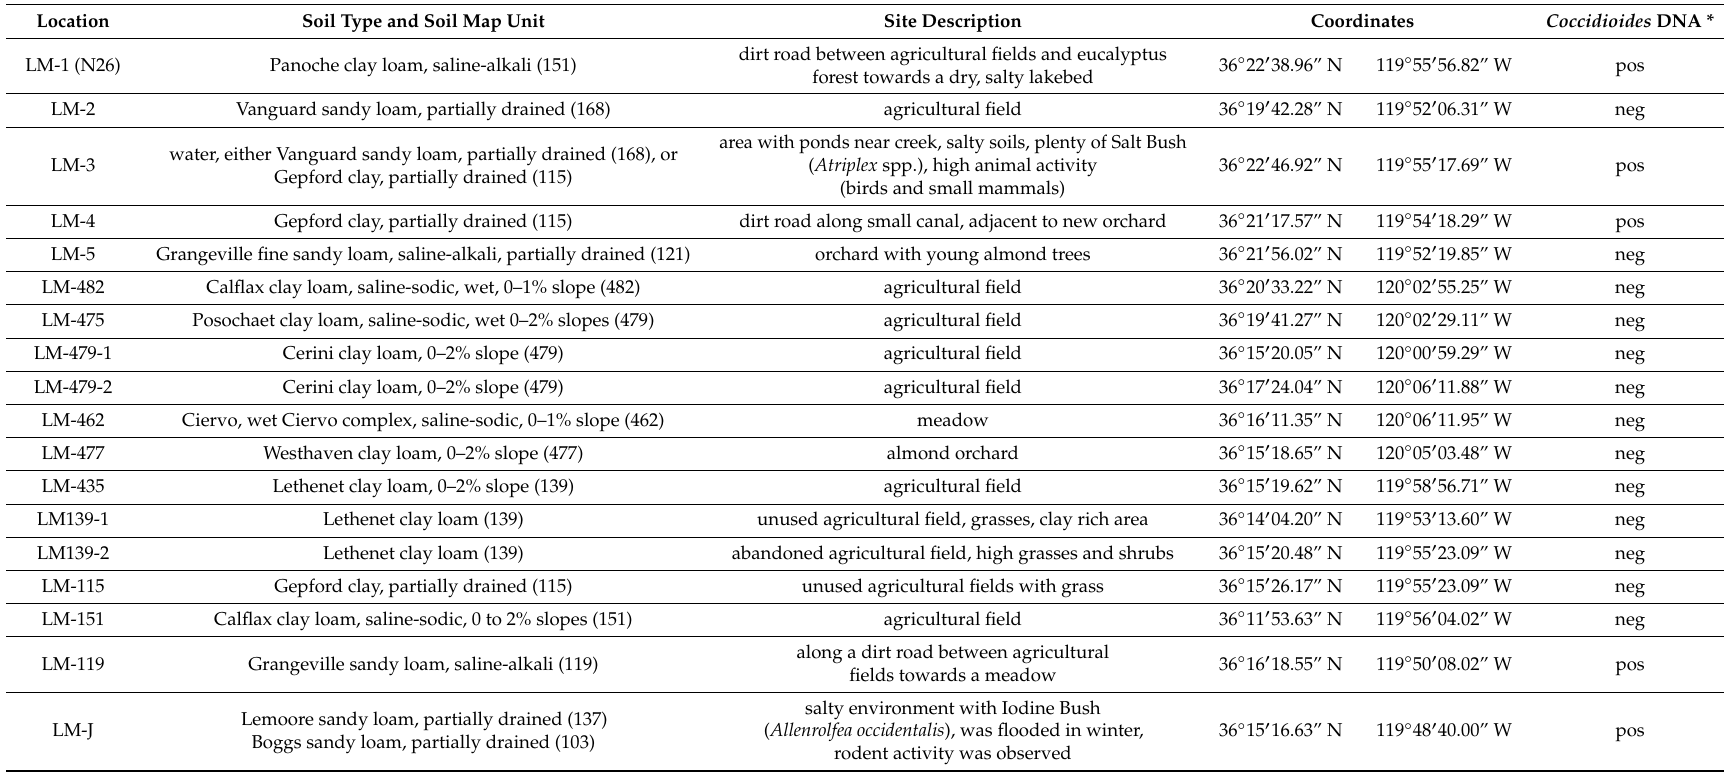
Table 2. Results of Coccidioides DNA testing at sampling sites near NAS